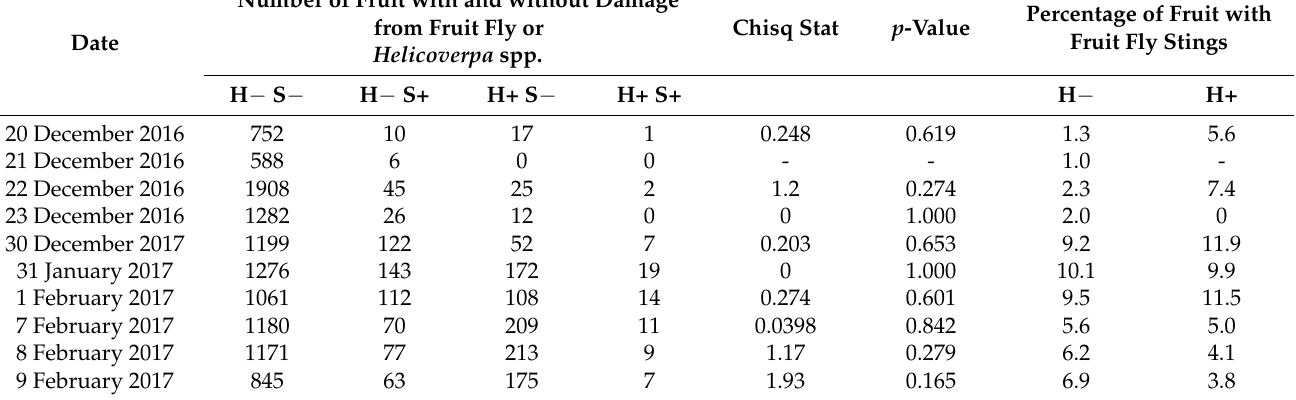
Bactrocera tryoni stings and Helicoverpa spp. damage across all sampling